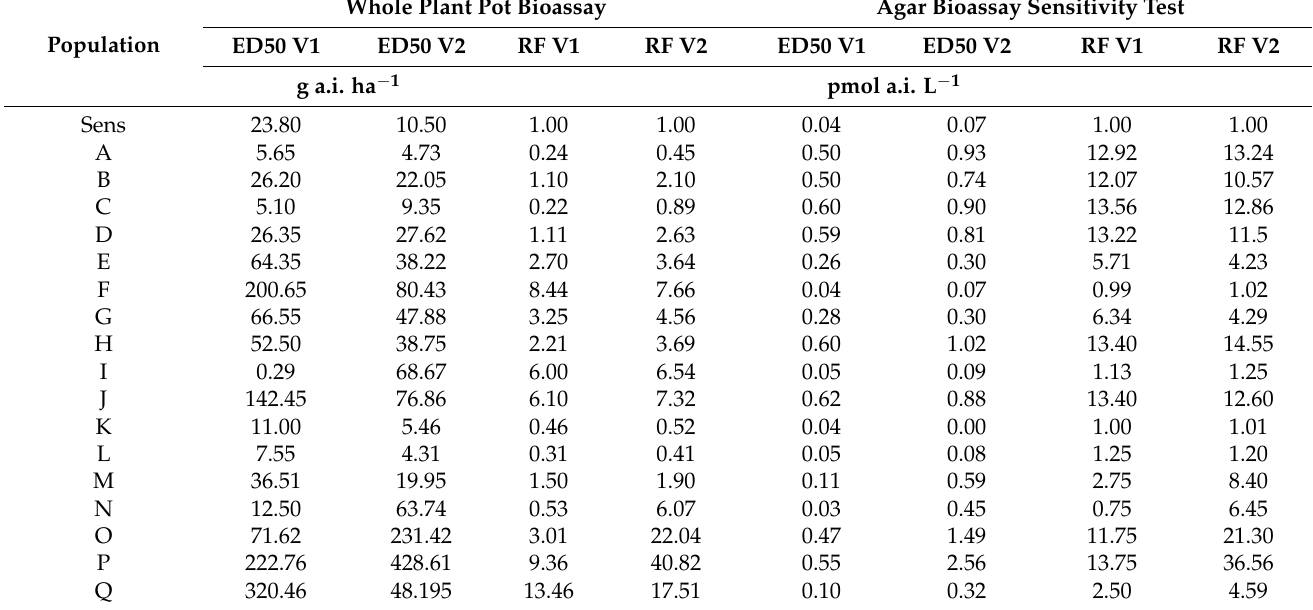
Table 2. Evaluation of sensitivity of the A. myosuroides populations to flufenacet in a whole plant pot bioassay in greenhouse and agar based resistance test under controlled environmental conditions in a climate chamber. Whereas ED50 = herbicide dosage causing 50% reduction in the relative dry matter content and RF = sensitivity factor. Whole plat pot bioassay